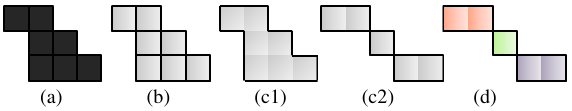
Figure 2. (a) Raster object, (b) raster object interpreted as BRep, (c1+c2) raster objects modelled as GM_CompositeSurface, (d) raster object modelled as